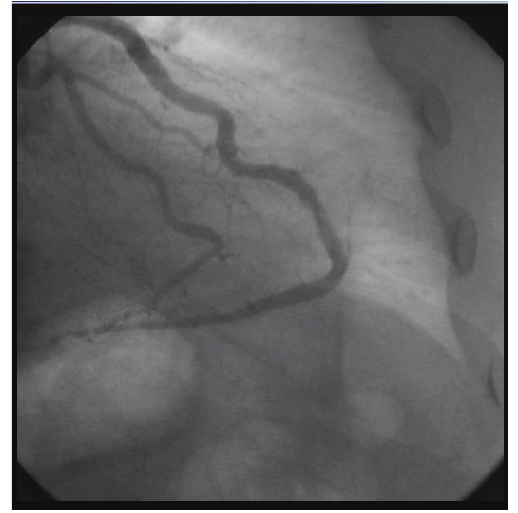
Figure 4: Coronary angiogram in the right anterior oblique view after deployment of the stent. Well-deployed stent is seen without any residual